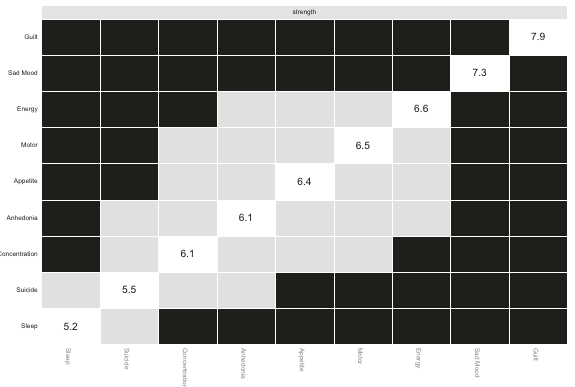
Fig. 4 Estimation of node strength difference by bootstrapped difference test. Bootstrapped difference tests between node strength of factors. Gray boxes indicate nodes that do not signi fi cantly differ from one-another. Black boxes represent nodes that differ signi fi cantly from one another ( α = 0.05). White boxes show the values of node